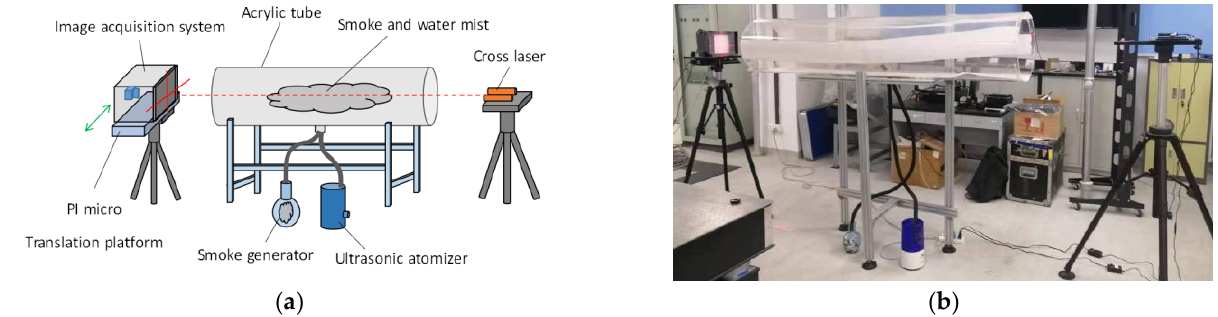
Figure 22.(a) Experimental schematic diagram. (b) Experiment procedure picture under smoke and water mist environ- ment.